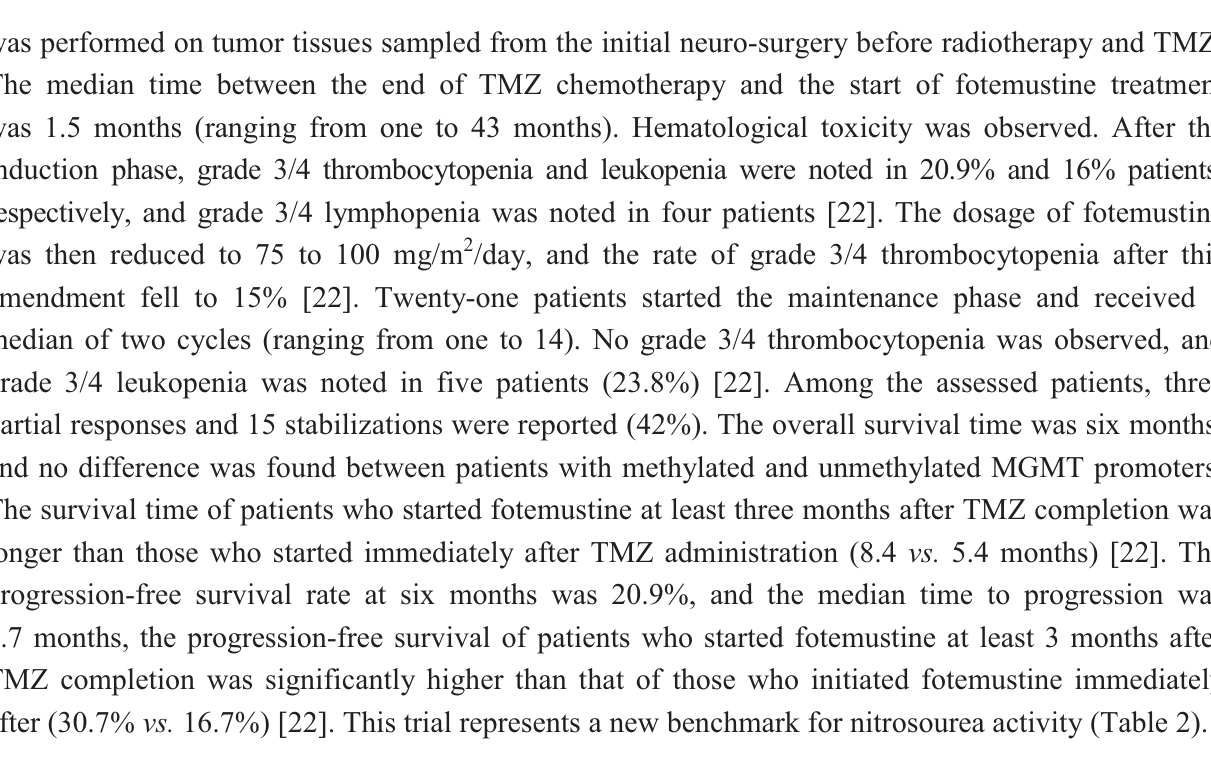
Table 2. Fotemustine post-temozolomide